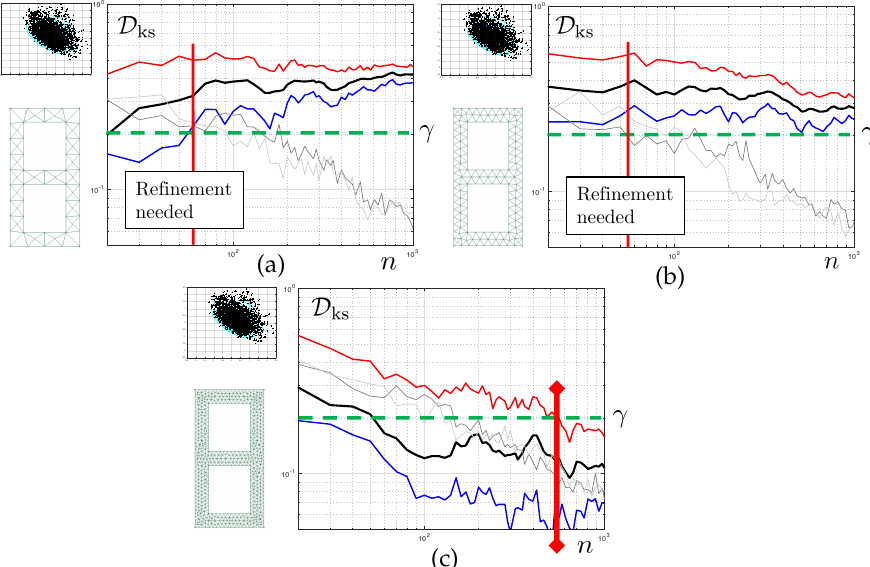
Figure 8. Convergence of the KS distance as a function of the number of Monte-Carlo samples in each chain (black line, with confidence interval represented by the area between the blue and red lines). The mesh used is represented schematically on the left-hand side of each of the graphs in ( a – c ). The data is composed of a unique noisy measurement of the first eigenfrequency. The quantity of interest is here the first elasticity parameter, in log scale. The grey lines are an indicator of the bias of the KS distance estimate, which decreases with the sample size. The bias should be be small for the estimate to be robust, but not too small so as to avoid running unnecessarily long chains using meshes that are too coarse for our needs. Sufficiently accurate results are obtained with the third